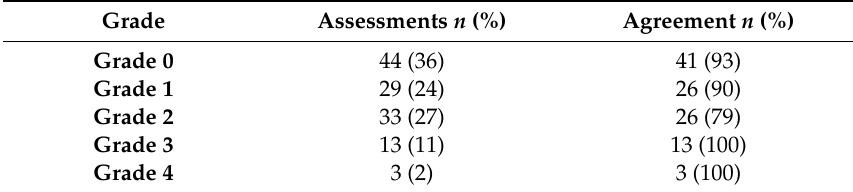
Table 1. Agreement between assessors by symptom